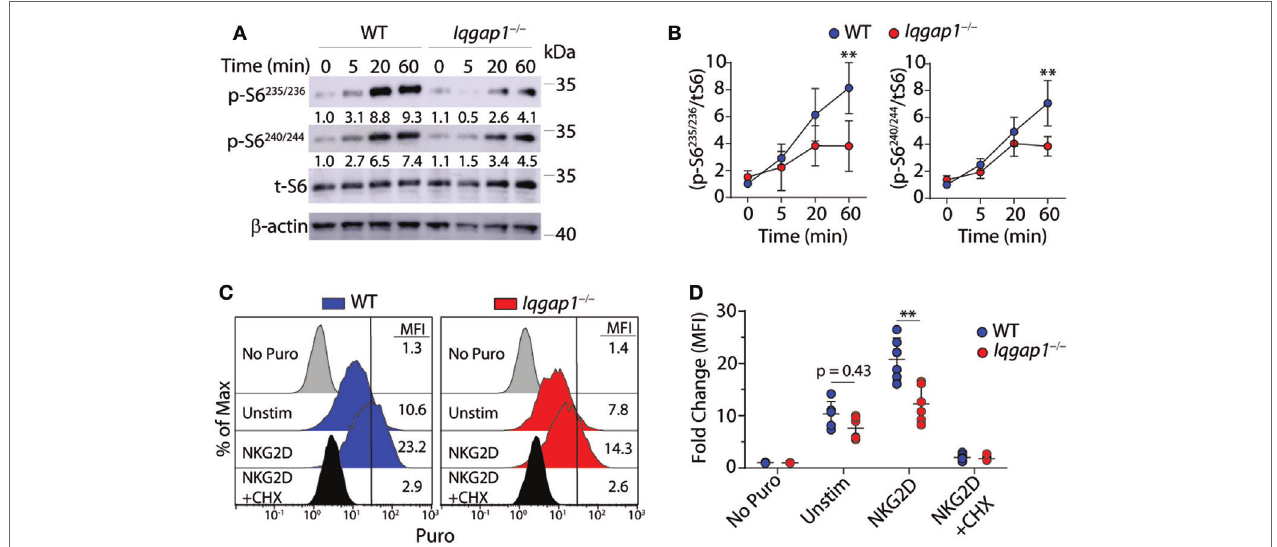
FigUre 8 | IQ domain-containing GTPase-activating protein 1 (IQGAP1) promotes sustained S6 activation and global protein synthesis in natural killer (NK) cells. (a) Phosphorylation of S6 at Ser 235/236 and Ser 240/244 was evaluated by western blot in IL-2 cultured wild-type (WT) and Iqgap1 − / − NK cells at the indicated times post-NKG2D stimulation. Total S6 was used to calculate representative fold changes which are shown relative to unstimulated WT NK cells and quantification of four independent western blots is shown in (B) for both S6 phosphorylation sites. Global protein synthesis in WT and Iqgap1 − / − NK cells was assessed by puromycin incorporation as described in the Materials and Methods section. (c) Representative histograms of puromycin incorporation gated from CD3 ε − NK1.1 + NK cells are labeled with MFIs and (D) fold change in MFI was calculated relative to WT NK cells not treated with puromycin. Cycloheximide (CHX) was added during the experiment as a negative control for global protein synthesis. Error bars represent SD using four to six mice in at least two independent experiments, ** p < 0.01 using two-way ANOVA accounting for multiple